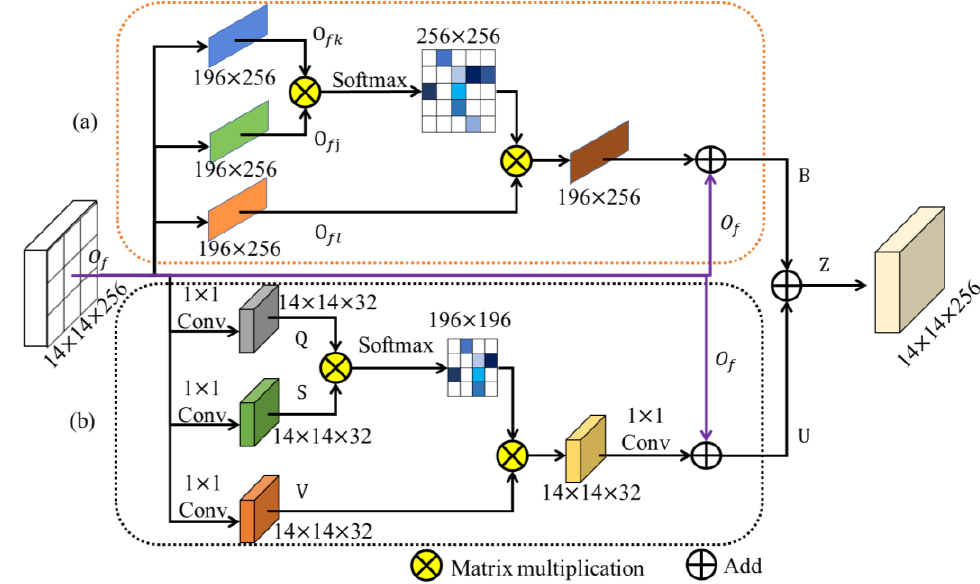
Figure 3. This figure introduces the mixed attention module of the SEAGNET. ( a ) Denotes the channel attention module and ( b ) denotes the spatial attention module.